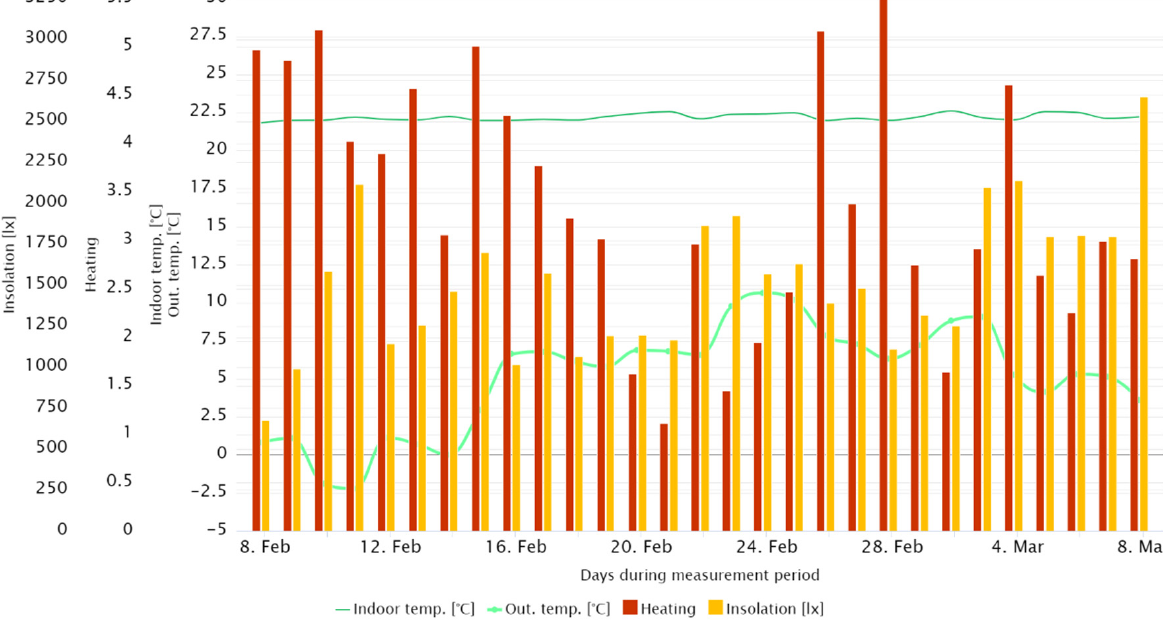
Figure 7. Daily averages of the internal temperature for room 124 referring to heating valve position, insolation, and outdoor temperature.